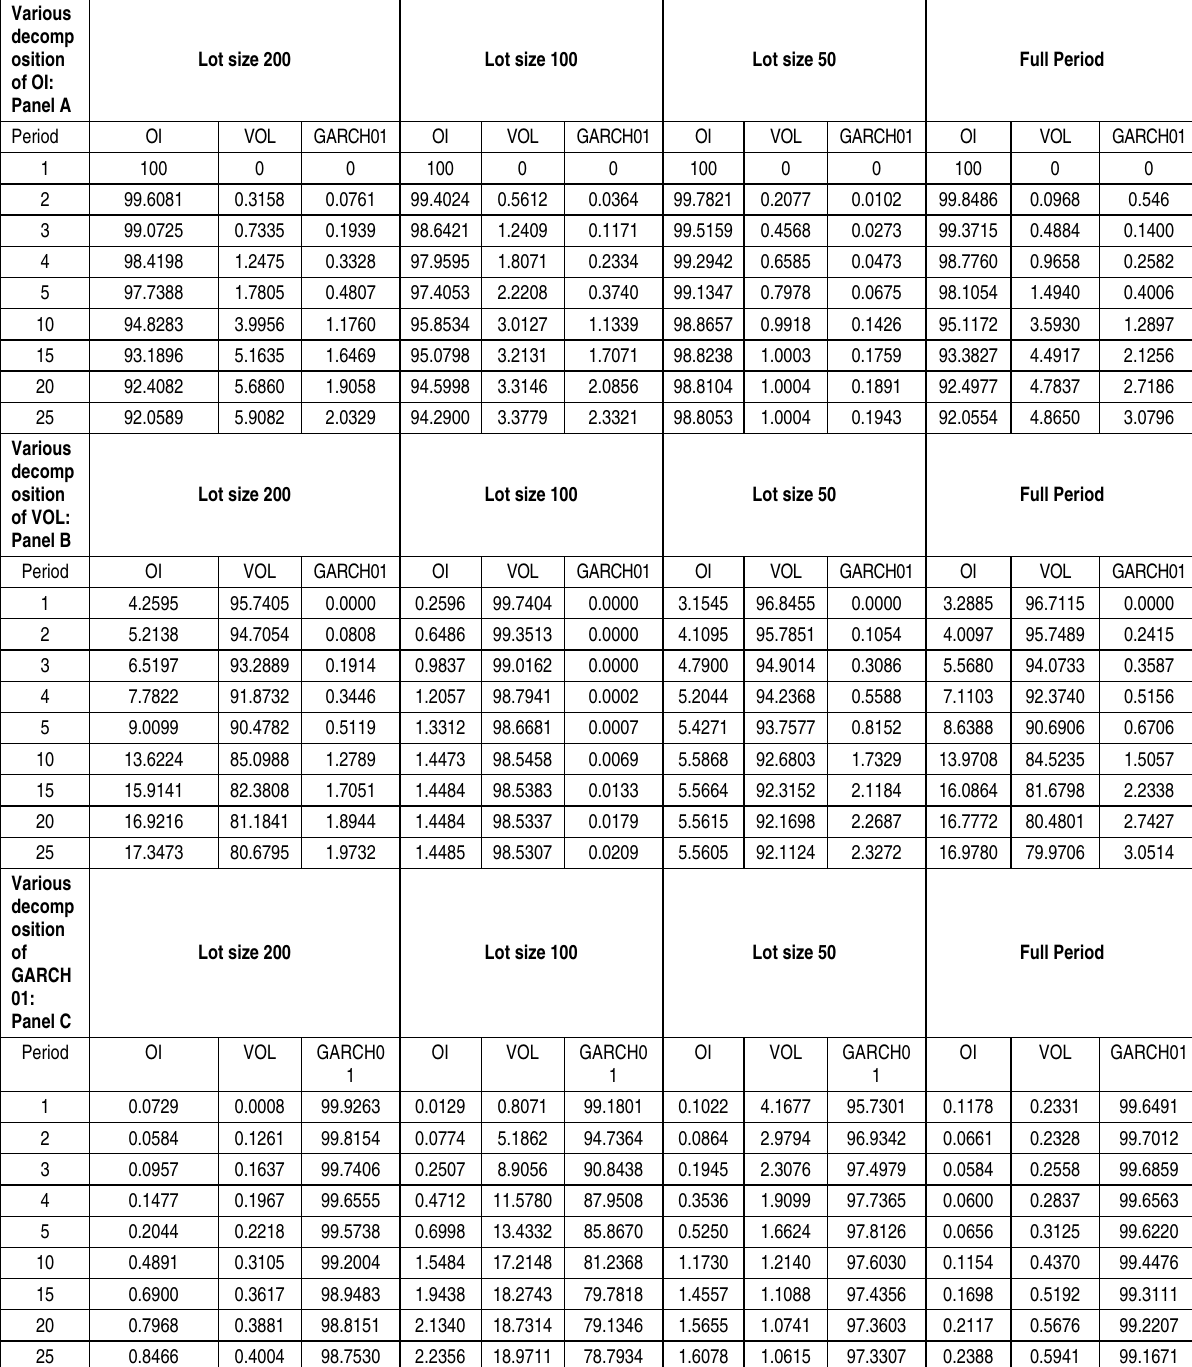
Table 3. Variance decomposition of open interest (OI_100), volume (VOL_100) and volatility (GARCH01). It explains the variance one variable caused by the shocks in another variable over three sub-periods for contract size starting with 200 (second column), followed by 100 (third column), 50 (fourth) and finally for the full period (fifth